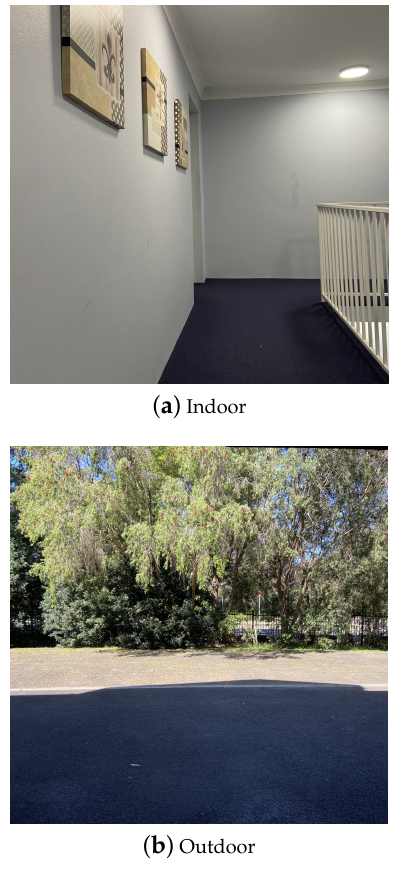
Figure 2. Experimental